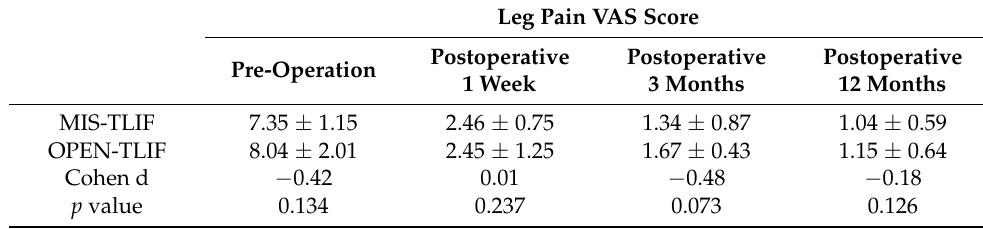
Table 4. Changes in leg pain VAS score during the follow-up.